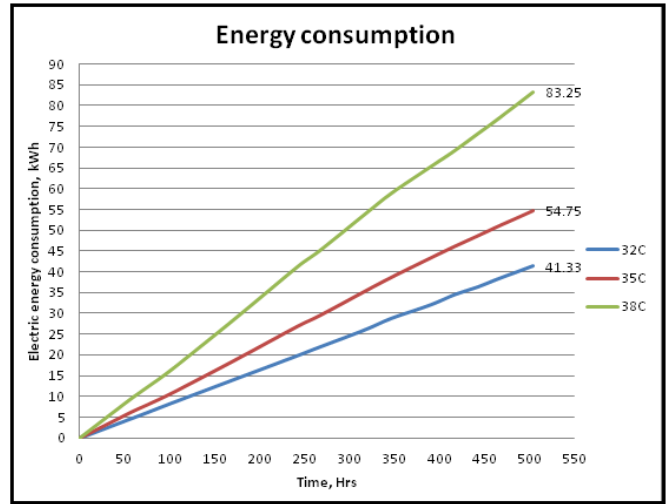
Figure 16. Average electric energies consumed at each temperature level. Table 10. The energy balance based on each optimisation criterion.